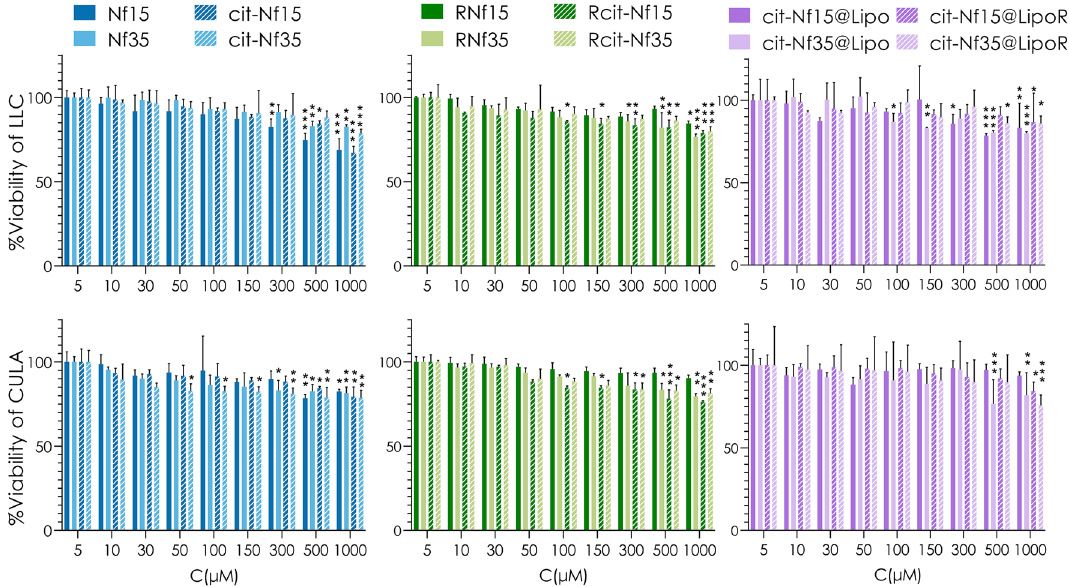
Figure 5. MTT assay results illustrating %Viability of LLC and CULA lung cancer cells after 24 h incubation with each formulation at different iron concentrations (Statistical analysis by two-way ANOVA test with Dunnett’s multiple comparisons test, *0.01 < p < 0.05, **0.001 < p < 0.01, ***0.0001 < p <